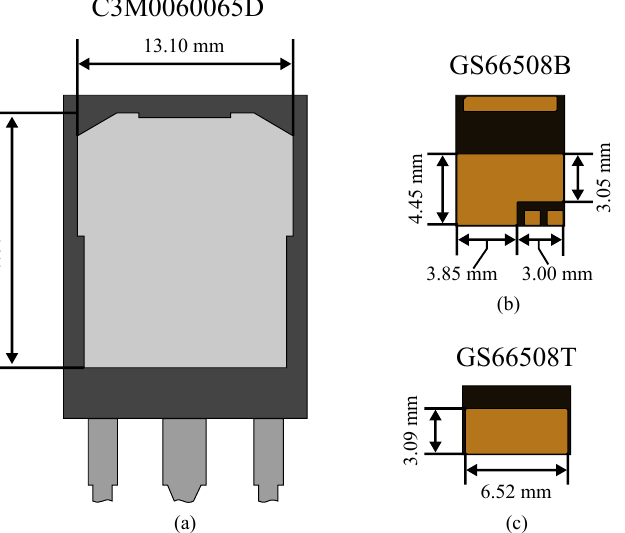
Figure 1. Size comparison between: ( a ) SiC MOSFET; ( b ) bottom-side cooled GaN e-HEMT; and ( c ) top-side cooled GaN e-HEMT. Thermal pad measurements are shown. The transistors are drawn to scale with each